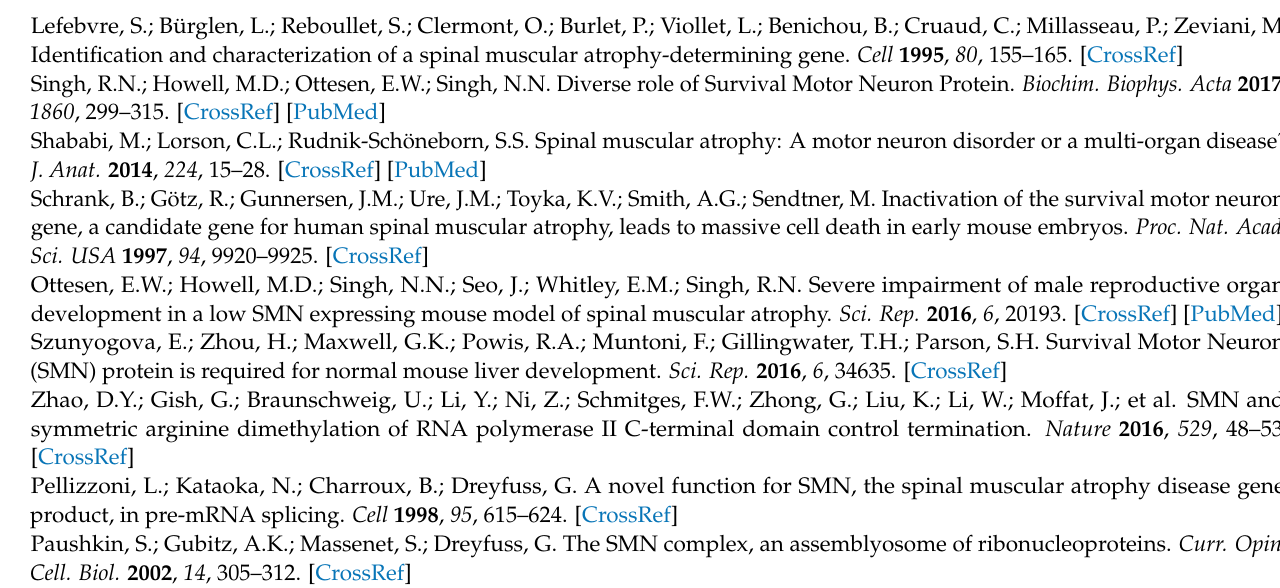
S3: Nucleolin localization, Figure S4: RIP Assay; Figure S5: Immunofluorescence Analysis of UBF1; Figure S6: RIP Assay; Figure S7: Dual staining for SMN and mTOR mRNA; Figure S8: PlaLock controls; Figure S9: Dual staining for SMN and mTOR mRNA; Figure S10: Puro-PLA control; Table S1: Oligos used in this